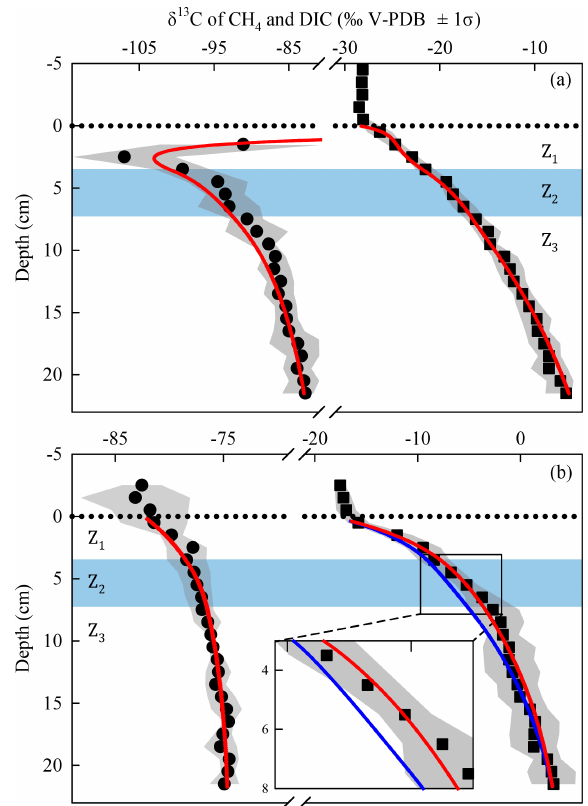
Figure 4. Comparison of the simulated (lines) and measured av- erage ( n = 3) δ 13 C profiles of CH 4 (circles) and DIC (squares) in the porewater of Lake Tantaré Basin A (a) and Lake Bédard (b) . The dotted horizontal line indicates the sediment–water interface. The variability in δ 13 C values ( ± 1 standard deviation – σ ) related to the spatial heterogeneity within the sampling area is shown by the grey area fills. The zone Z 2 is delimited by the blue area fill. In panel (b) , the blue lines are the profiles simulated with the default rate values and optimal α i and f values as described in Sect. S2.2.1. The red lines in panel (b) are the profiles simulated with α 2 values of 0.980–0.984 (see Sect. 4.1 for